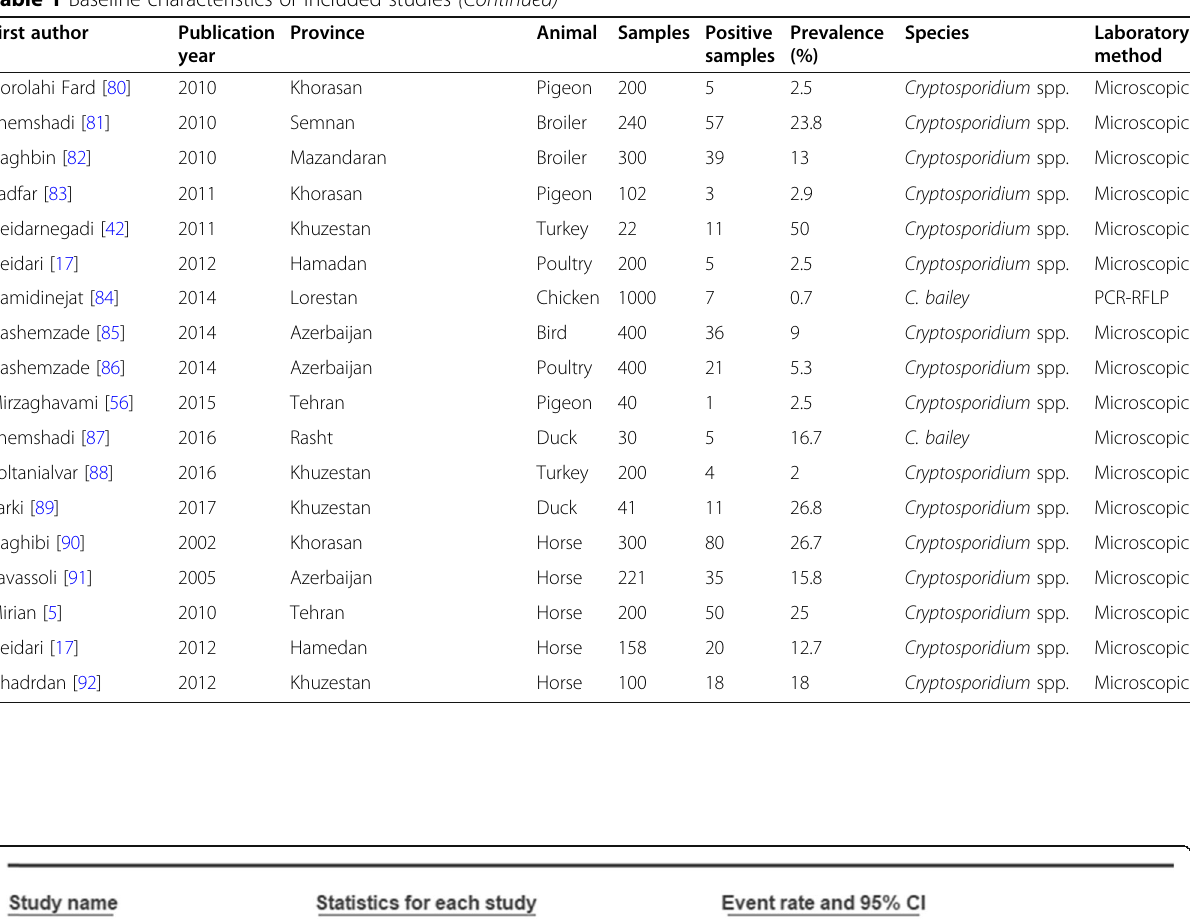
Table 1 Baseline characteristics of included studies (Continued)